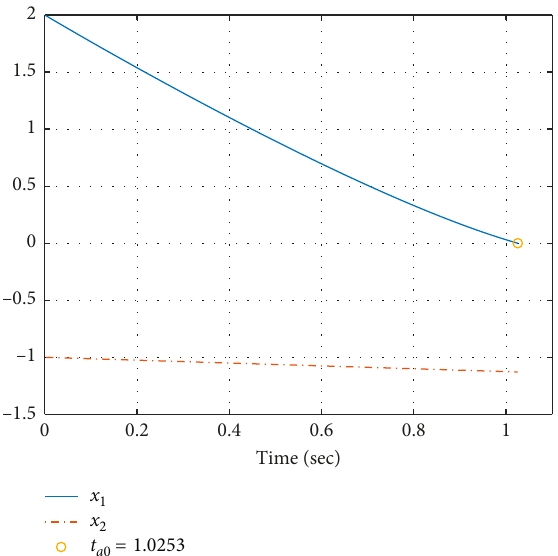
Figure 5: Finite-time convergence with the zero initial condition of the state ( A � ( −